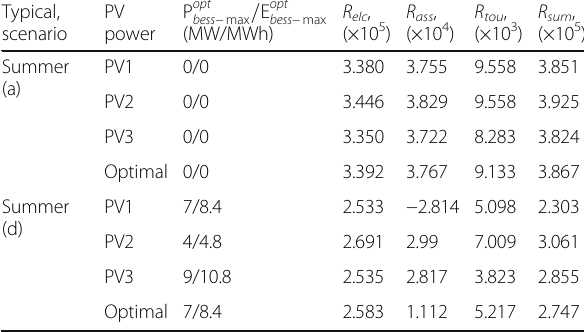
2.203 million yuan. Table 3 The operation mode and revenue of the typical scenario (a) and (d) of